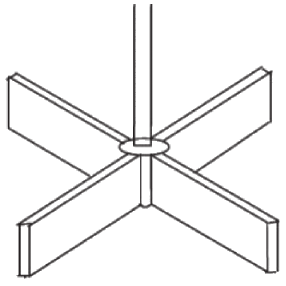
Figure 3: Four-blade stirrer [8].